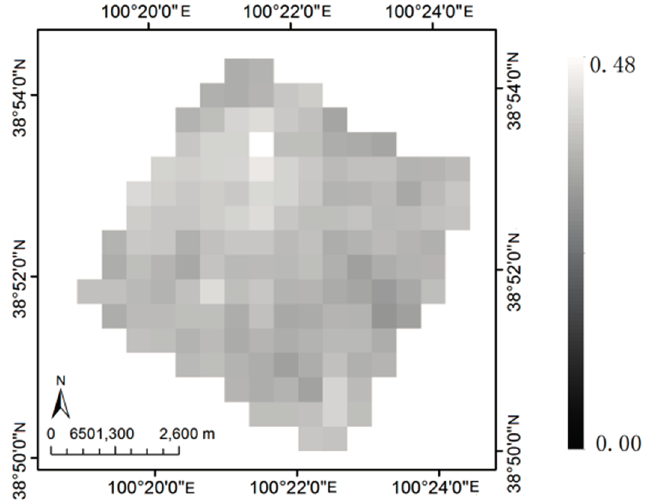
Figure 9. The isotropic kernel coefficients of the cropland portion of each MODIS pixel in Band